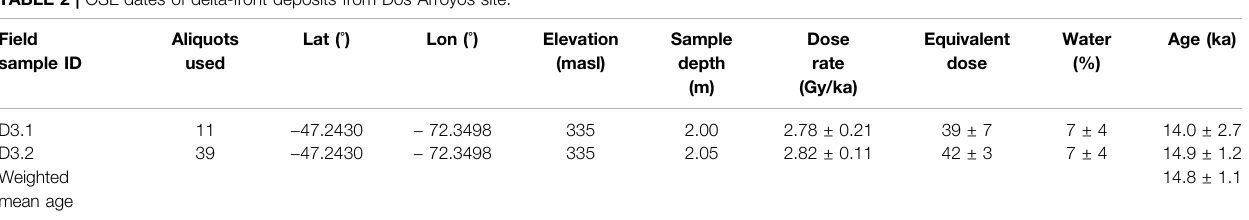
TABLE 2 | OSL dates of delta-front deposits from Dos Arroyos